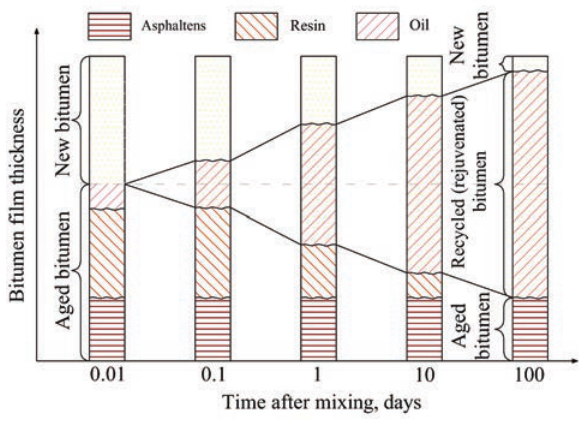
Fig. 5. The dynamic model of mixing the aged and virgin bitumen layers which coat the aged particle of the recycled